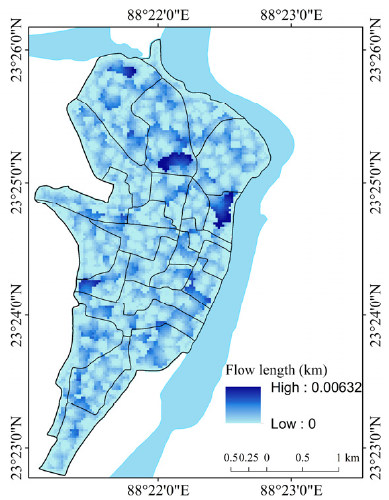
Figure 33. Flow length (2015).